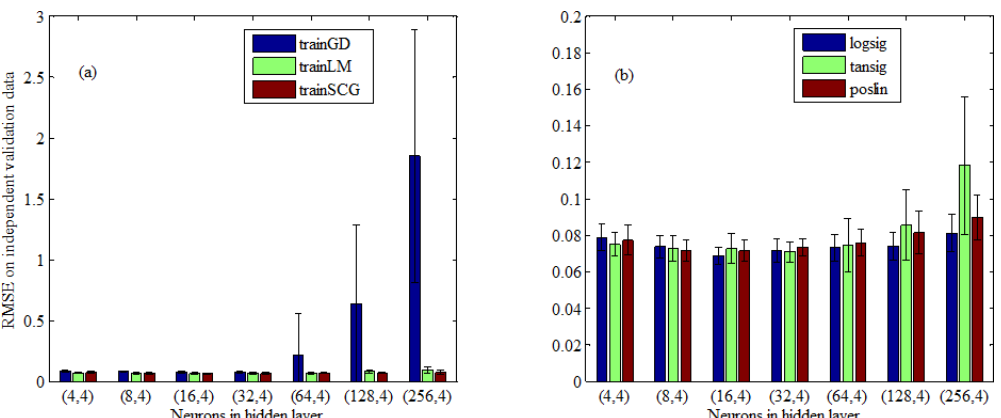
Figure 5. Comparison of the performance of different training functions and transfer functions on independent validation data. (a) Three training functions: gradient descent backpropagation (trainGD), Levenberg–Marquardt backpropagation (trainLM) and scaled conjugate gra- dient backpropagation (trainSCG). (b) Three transfer functions: log-sigmoid transfer function (logsig), hyperbolic tangent sigmoid transfer function (tansig) and positive linear transfer function (poslin). Bars show the mean and standard deviation of the root mean square error over a 10-fold cross-validation, for different numbers of neurons in the first hidden